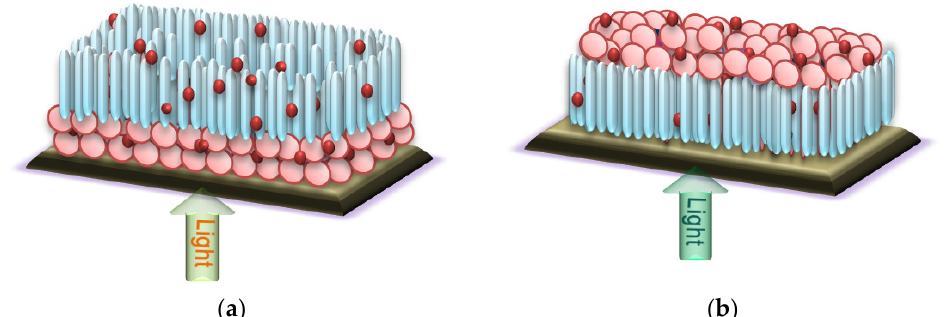
Figure 5. Schematic diagram of ( a ) nanorods/nanospheres and ( b ) nanospheres/nanorods.